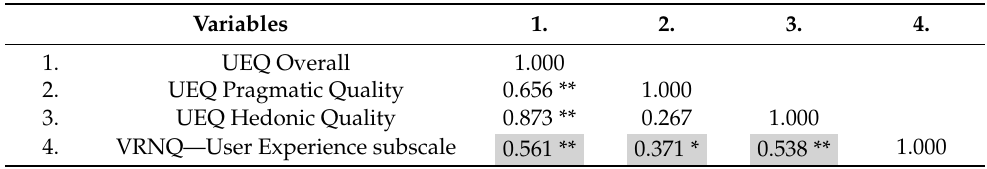
Table 16. Correlation matrix for HA_NORF condition—Spearman ( ρ ) correlation coefficients for combined user experience measures ( n = 4).